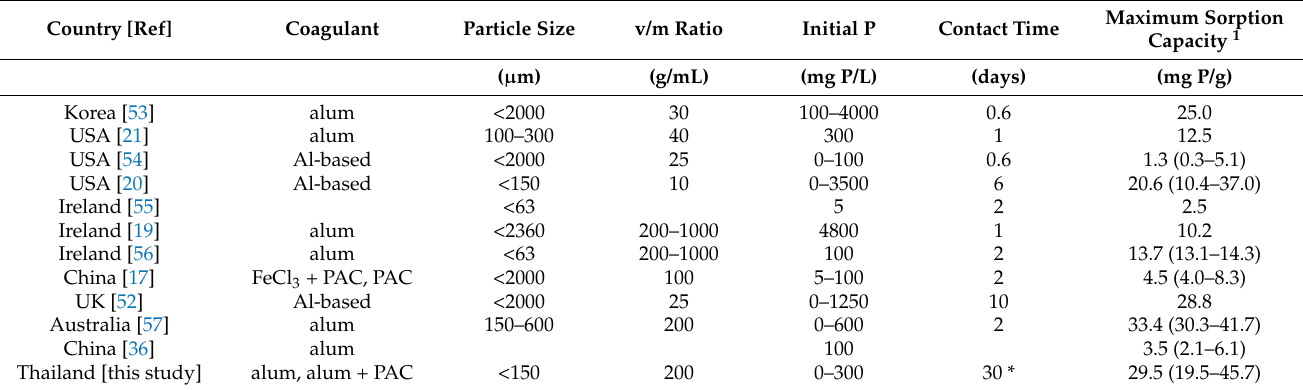
Orthophosphate sorption capacities of Al-based DWTRs at circumneutral pH determined from Langmuir